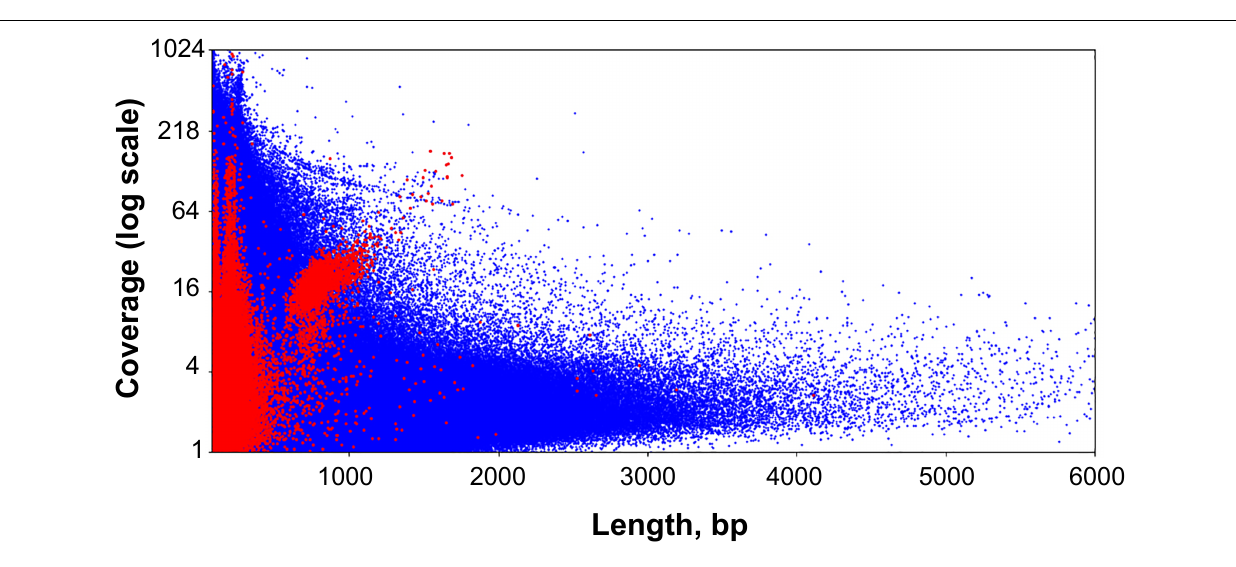
(Kolmogorov–Smirnov test p -value is 0.999) when